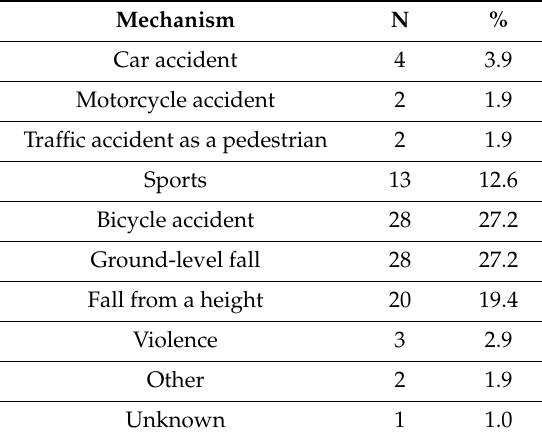
Table 3. Mechanism of injury ( n =